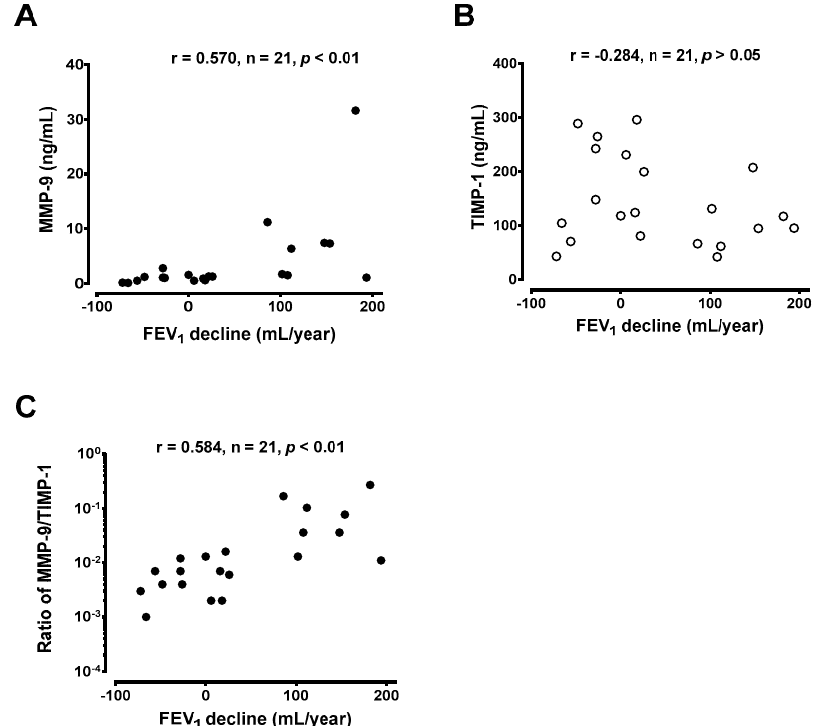
Figure 7. Correlation of the level of ( A ) MMP-9 and ( B ) TIMP-1 released from alveolar macrophages (AMs) cultured for 24 h with the magnitude of FEV 1 decline per year (mL/year) from patients with chronic asthma receiving inhaled corticosteroids. ( C ) Correlation of the MMP-9/TIMP-1 ratio in 24 h